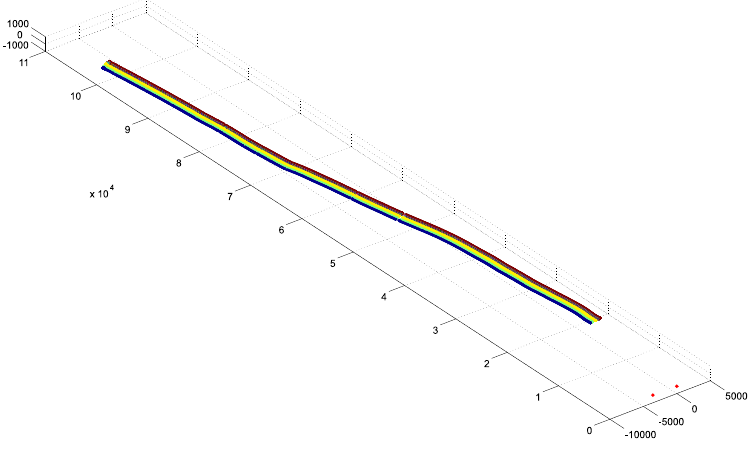
Figure 31. Kinematic tracking of the horizontal target from 20–110 m with d base ≈ 3